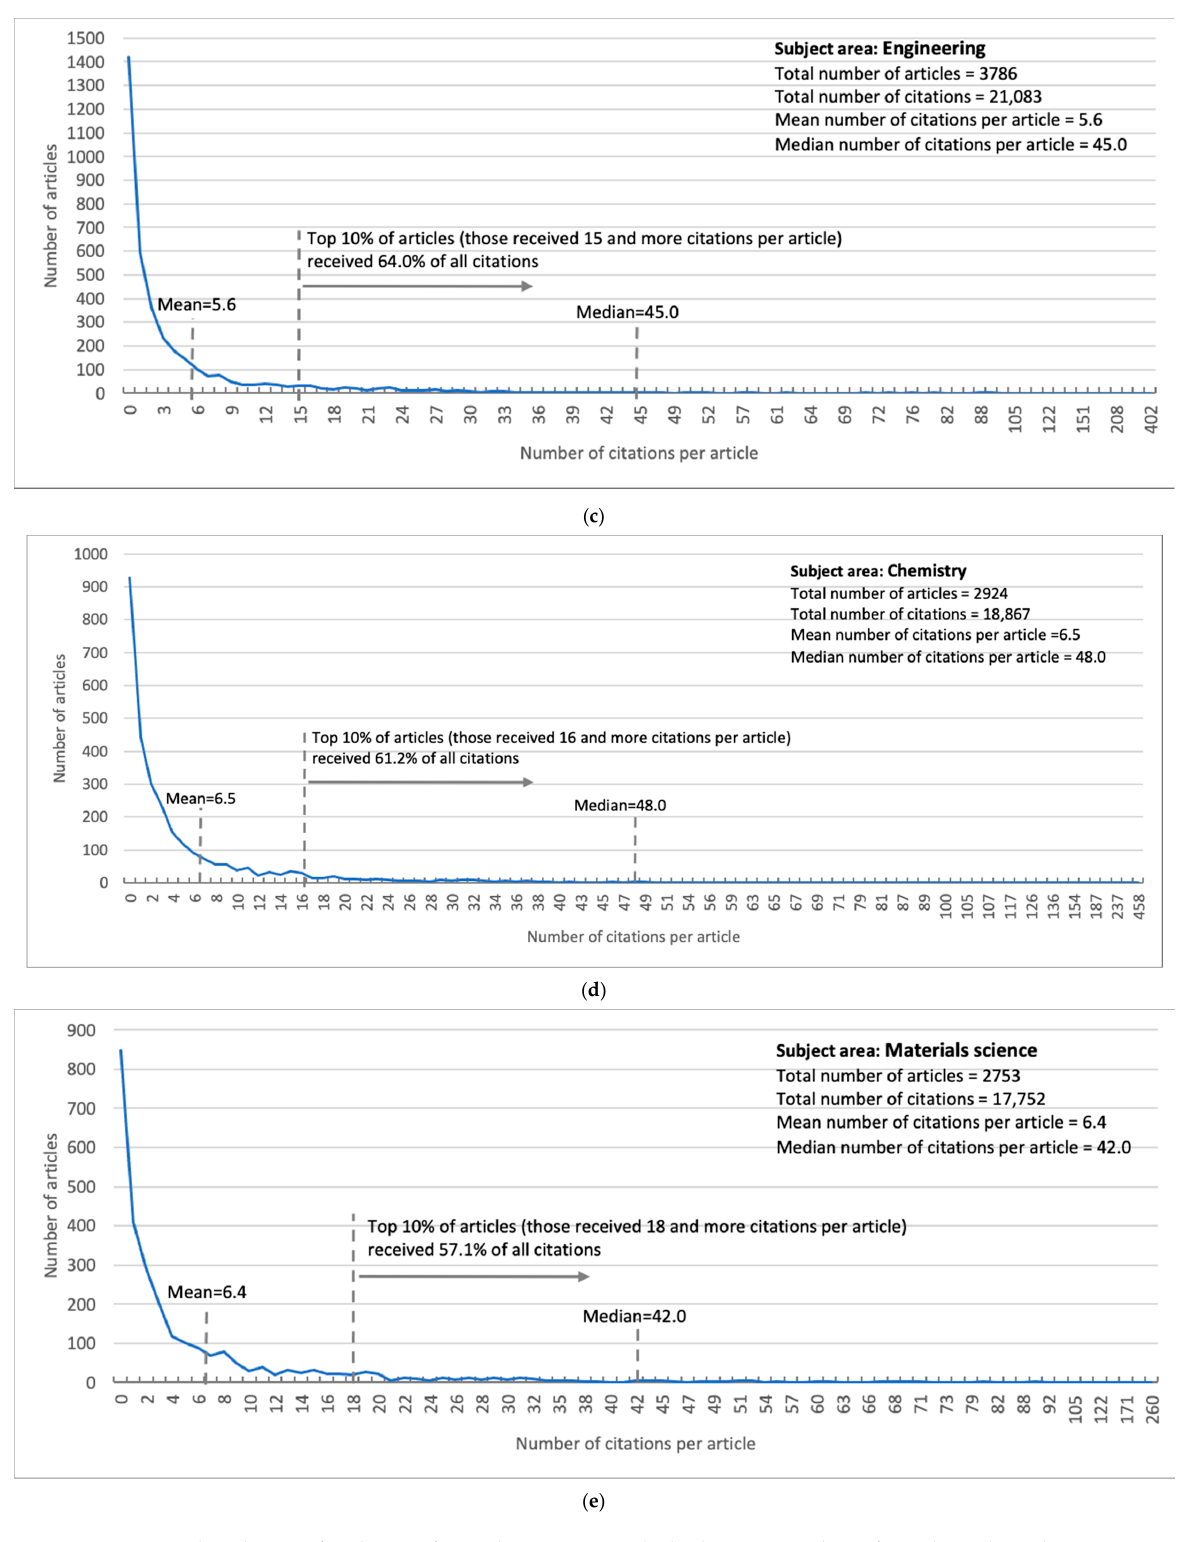
Figure A1. Citation distribution for the top five subject areas with the largest number of articles. The subject areas are: ( a ) Physics and Astronomy; ( b ) Social Sciences; ( c ) Engineering; ( d ) Chemistry; ( e ) Materials